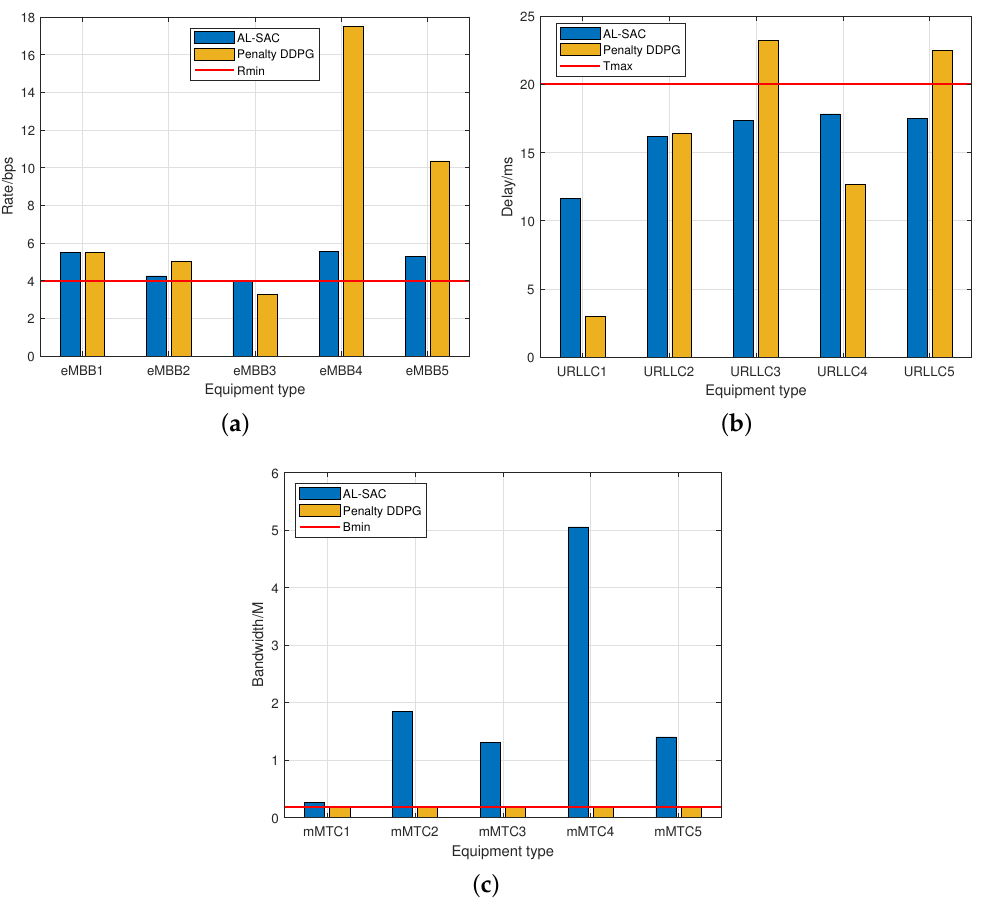
Figure 8. Network service constraints for devices in different network slices. ( a ) The achieved transmission rate of devices in eMBB network slice; ( b ) the achieved delay of devices in URLLC network slice; ( c ) the achieved bandwidth of devices in mMTC network